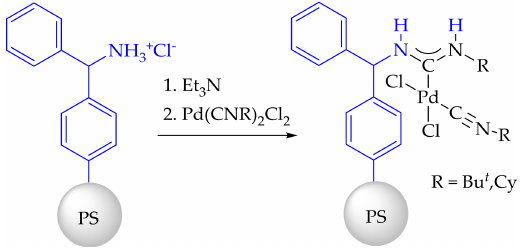
Scheme 1. Synthesis of polystyrene-supported ADC–Pd